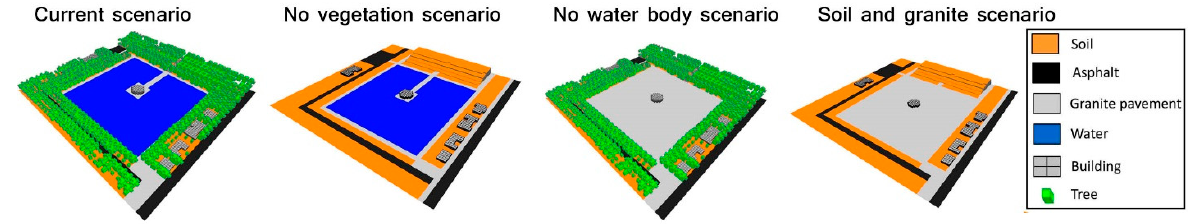
Figure 4. Representation of different simulation scenarios on ENVI ‐ met.